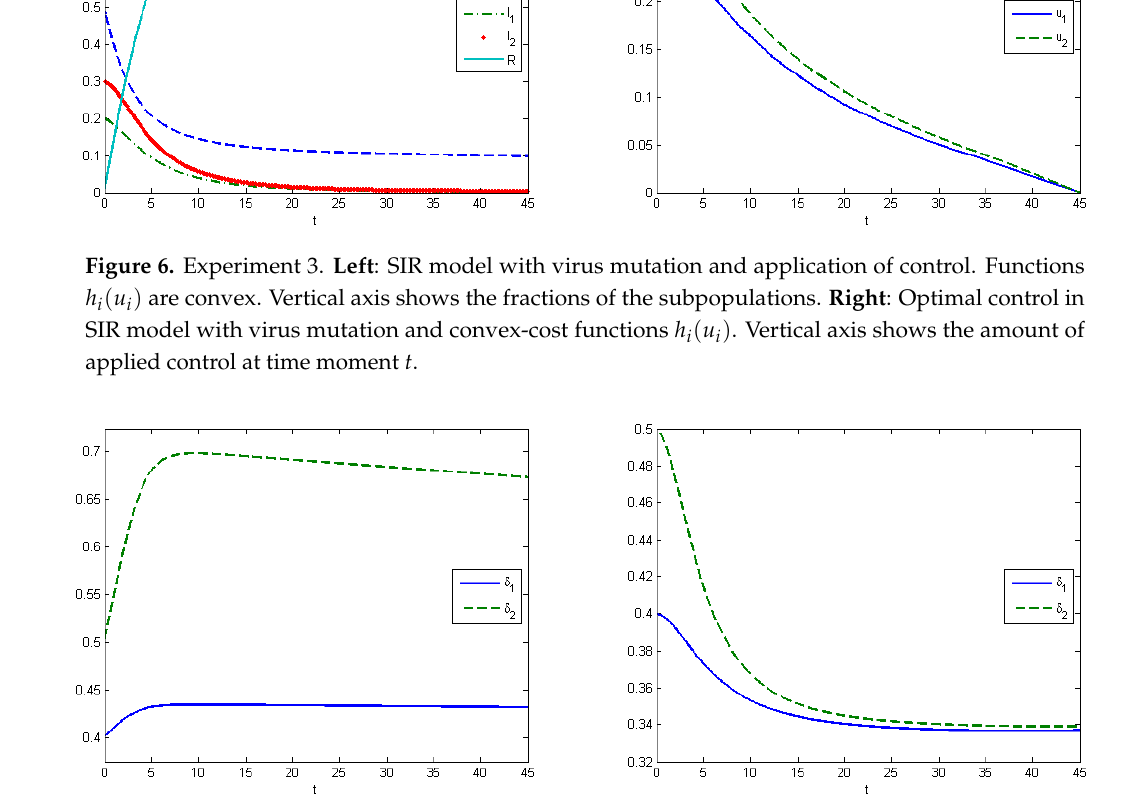
Figure 7. Left : Experiment 2. Infected rates of the SIR model with virus mutations (uncontrolled case). Utility-of-occupation functions were b 1 ( I 1 ) = I 1 and b 2 ( I 2 ) = I 2 . Cost functions were C 1 ( I 1 ) = 5 I 1 and C 2 ( I 2 ) = 2 I 2 . Infectious rates were δ 1 = 0.43 and δ 2 = 0.67. Right : Experiment 3. Infected rates of the SIR model with virus mutations (controlled case). Utility-of-occupation functions were b 1 ( I 1 ) = 2 I 1 and b 2 ( I 2 ) = 2 I 2 . Cost functions were C 1 ( I 1 ) = 5 I 1 and C 2 ( I 2 ) = 3 I 2 . Infectious rates were δ 1 = 0.339 and δ 2 =